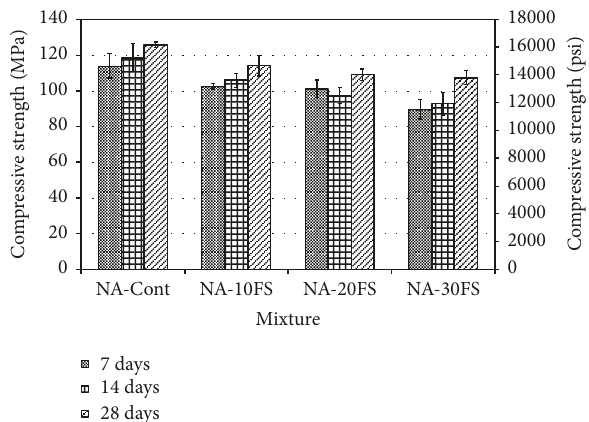
Figure 1: Compressive strength of manufactured (nonreactive) sand: foundry sand mixtures at 7, 14, and 28 days.